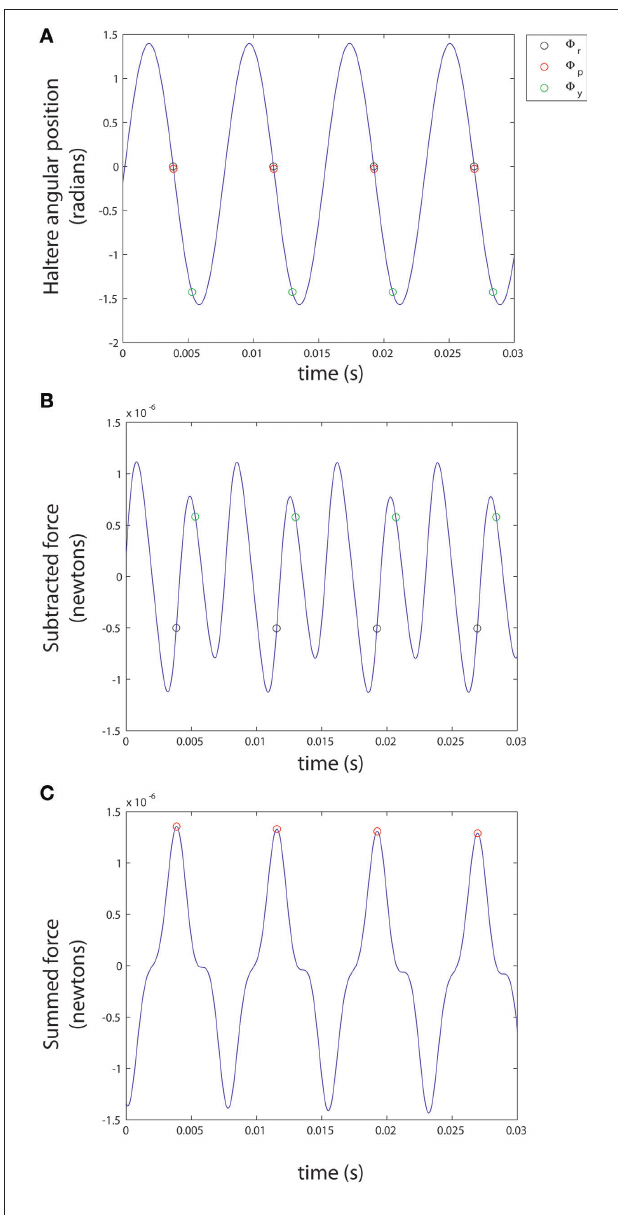
Figure 2 | Analysis of variables. (A) The sample points for pitch, roll, and yaw ( Φ , Φ and Φ ) are plotted against time on the graph of the haltere’s position ( Φ ) p r y given an initial haltere angle of 0 ° . (B,C) Φ on the graphs of the equations for F angular velocity with pitch, roll, and yaw components of 30 radians/s 2